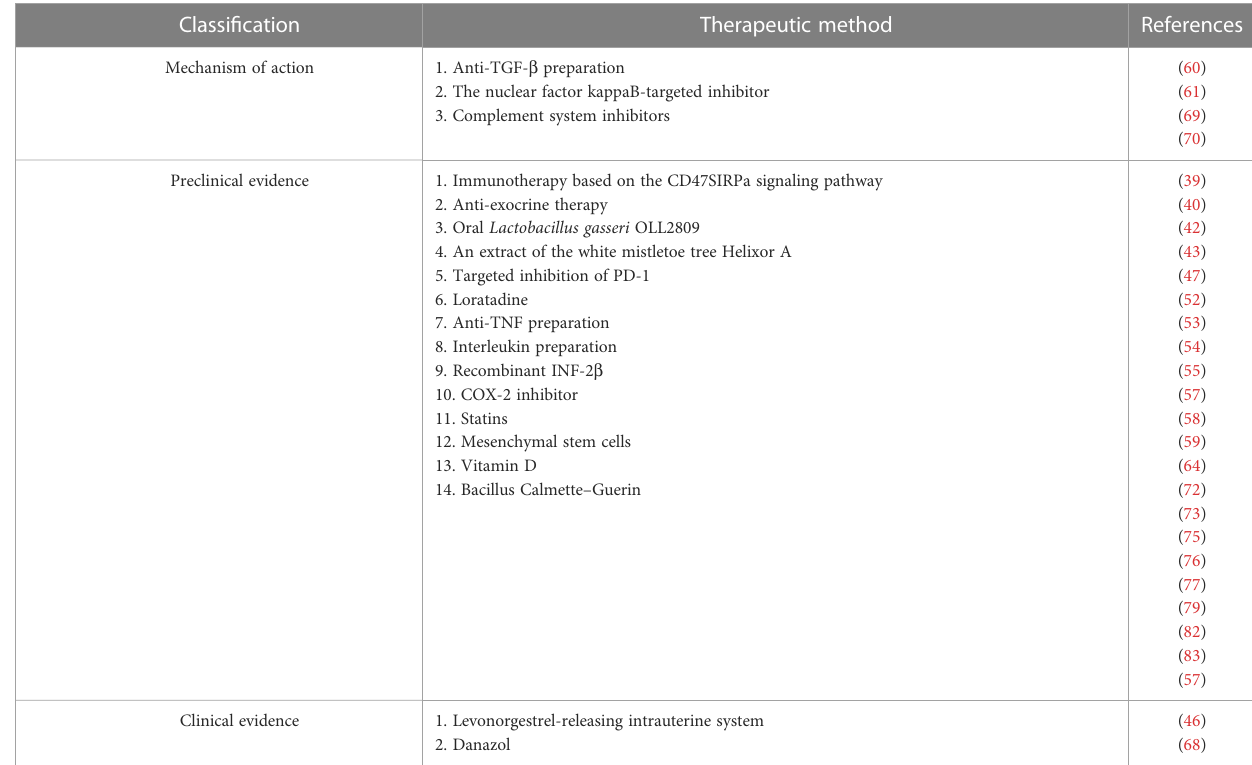
TABLE 1 Summary of immunotherapy